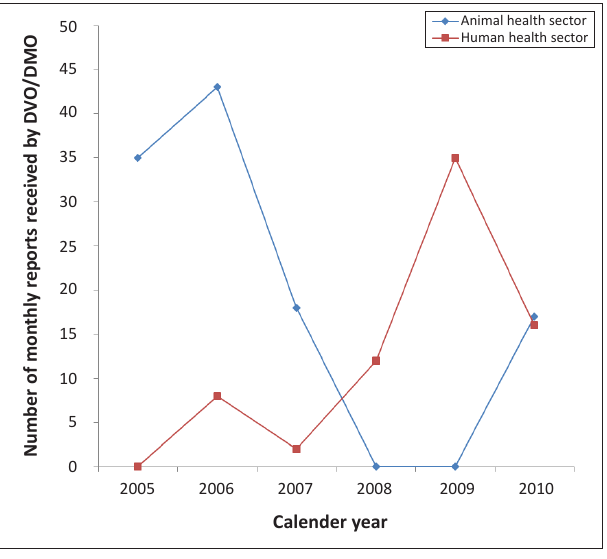
FIGURE 1: Efficiency of monthly disease reporting in the animal and human health sectors in Ngorongoro district from 2005 to 2010.